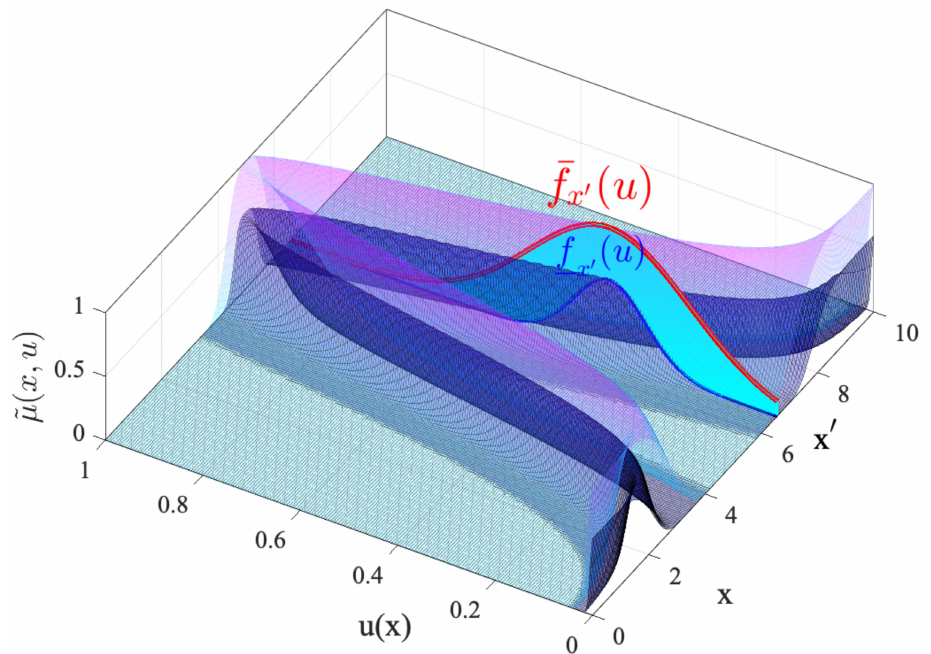
Figure 1. IT3-FSs„ with T3 MF, and an embedded vertical cut, with the footprint of uncertainty (FOU) in sky blue